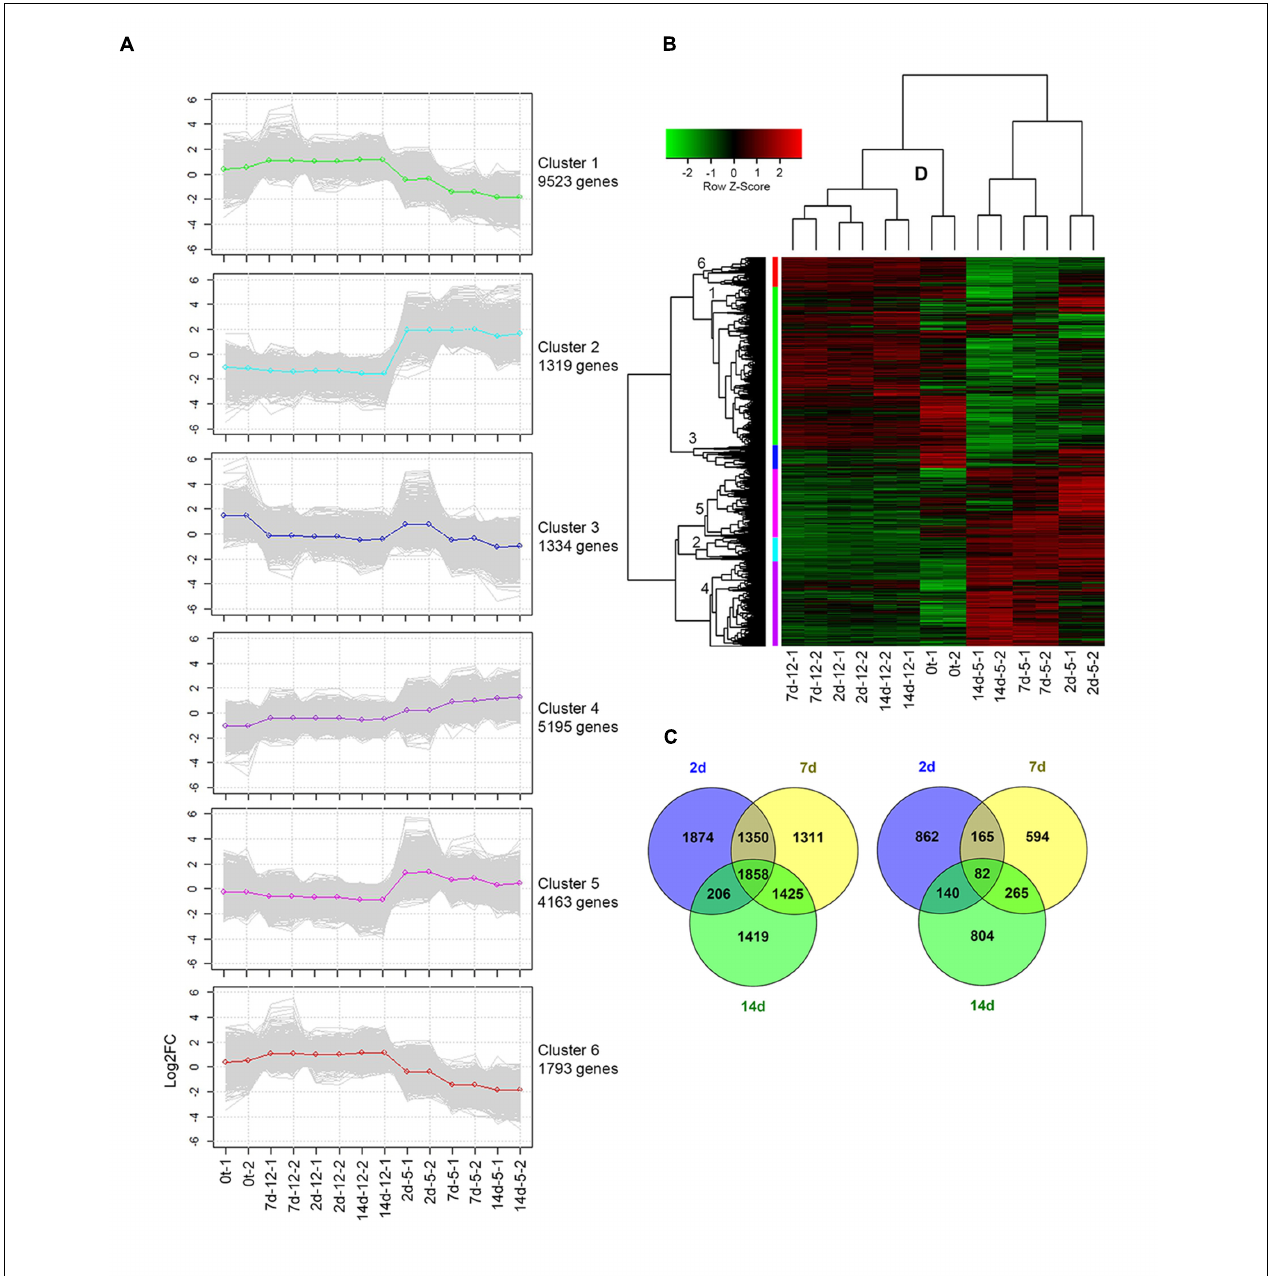
FIGURE 3 | Differential expression profile of transcripts following cold storage. (A) Plots present the expression patterns of six clusters at different time points. Gray lines mark the various gene profiles; green, light-blue, blue, purple, pink, and red lines represent the average expression profiles of clusters 1 to 6, respectively. (B) Heat map diagram showing the differential expression profiles of 12,355 genes of mango fruit at four sampling times: harvest (0t) and after 2, 7, and 14 days of cold storage at two different storage temperatures (5 and 12 ◦ C) with two biological replicates. (C) Upregulated and (D) downregulated genes in response to cold storage at 5 ◦ C compared to 12 ◦ C are presented by Venn diagram at different sampling times (2, 7, and 14